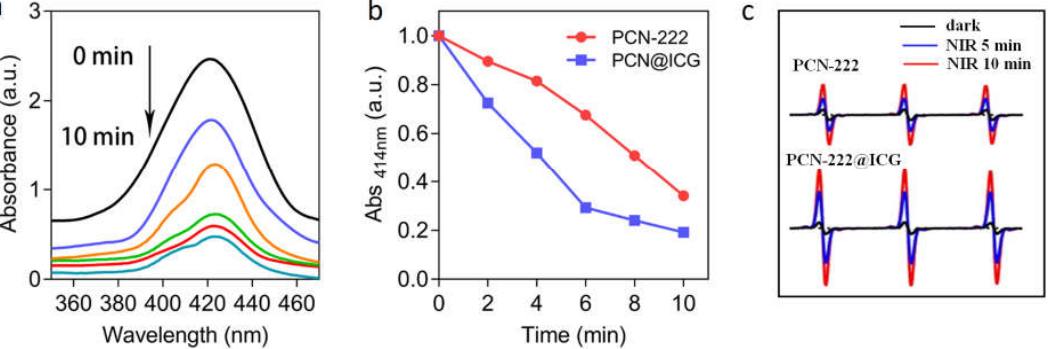
Figure 3. Photo-oxygenation capability of PCN−222@ICG. ( a ) UV-vis absorbance of DPBF in the presence of PCN−222@ICG when exposed to NIR light for 0–10 min (black to cyan represents 0 min to 10 min with a 2-min interval). ( b ) Comparison of UV-vis absorbance signal of DPBF at 414 nm between PCN−222 and PCN−222@ICG upon NIR light for 0–10 min. ( c ) ESR spectra of PCN@222 and PCN−222@ICG after exposure to NIR light for 5 min and 10 min.